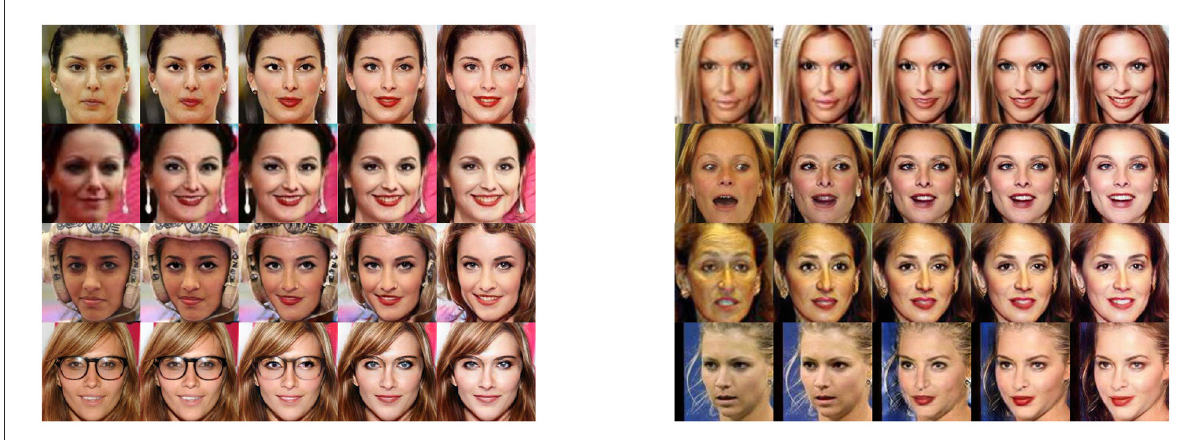
FIGURE4 Beauty degree adjustment by controlled beauty representation (the leftmost is the original input, from left to right: light to heavy